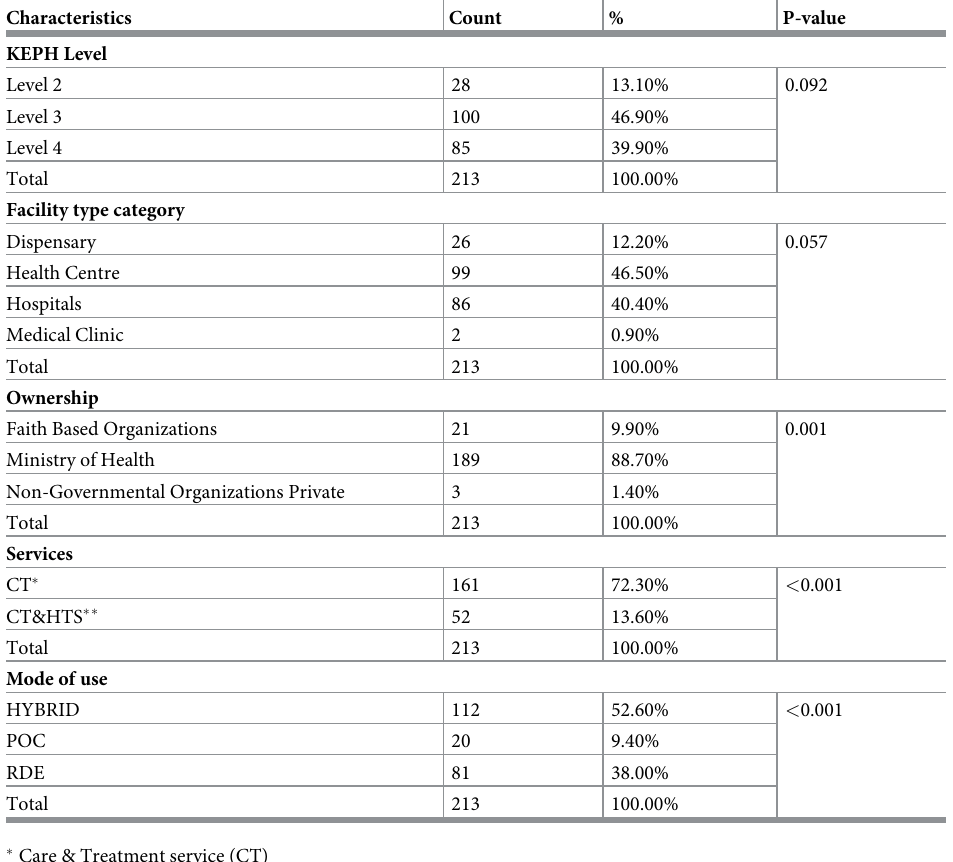
Table 2. Frequency distribution for the facility characteristics (n = 213).